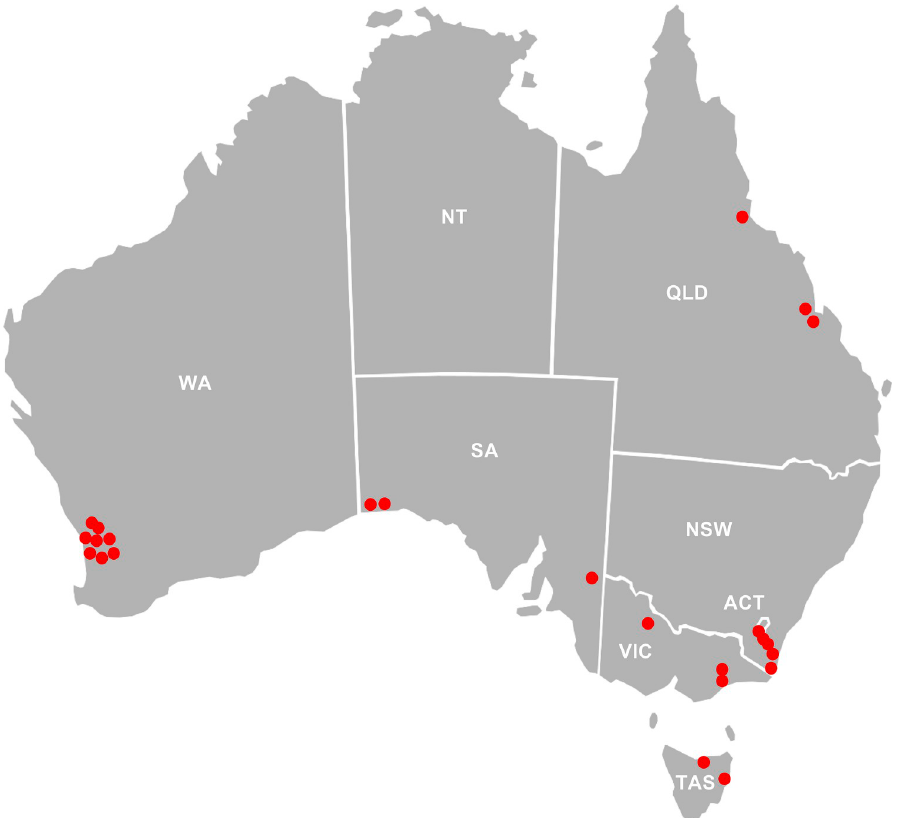
Fig 1. Origin of samples. Australian states and territories from which nurse bees were collected for this study. Red dots indicate the location of apiaries sampled in this study. NSW, New South Wales; VIC, Victoria; WA, Western Australia; QLD, Queensland; SA, South Australia; TAS, Tasmania; ACT, Australian Capital Territory.